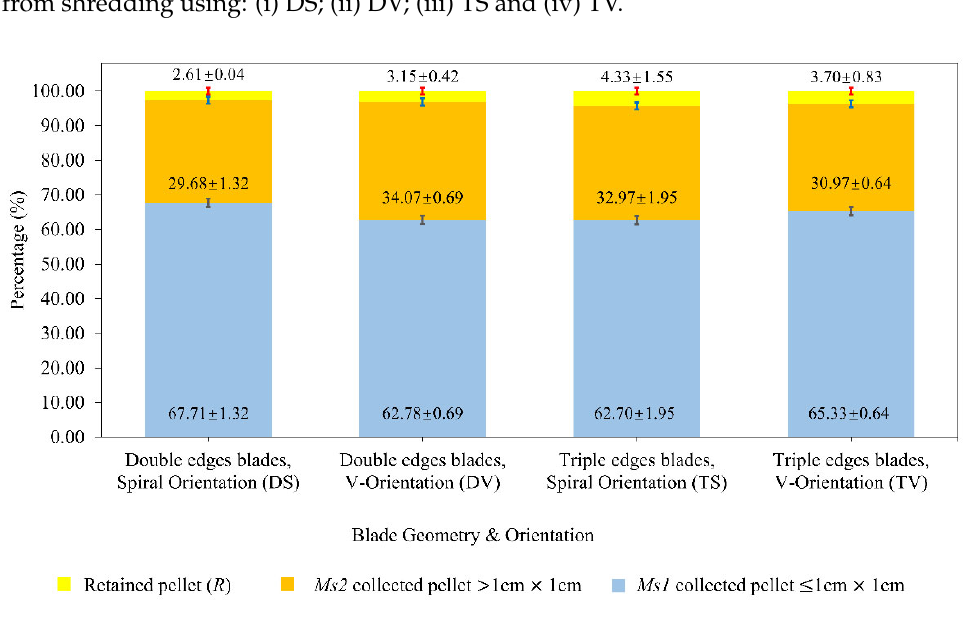
Figure 16. Mass percentage of retained pellet ( R ) and pallets with size >1 cm × 1 cm ( Ms2 ), and ≤ 1 cm × 1 cm ( Ms1 ) obtained from shredding using DS, DV, TS, and TV blades and